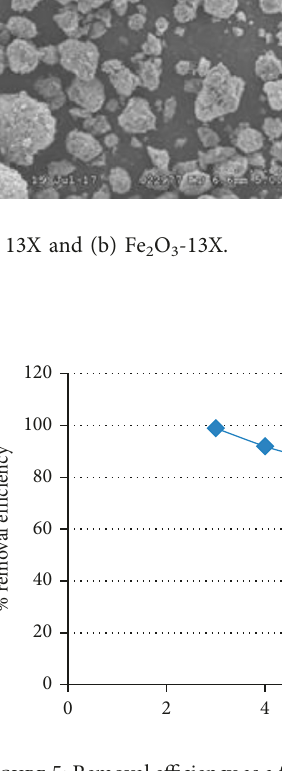
1000mg/1L solu- (cid:30)